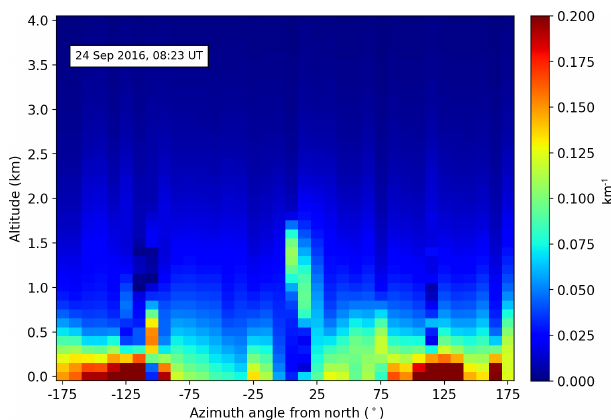
Figure 17. Retrieved aerosol extinction profiles around the mea- surement site for the azimuthal scan shown in Fig.